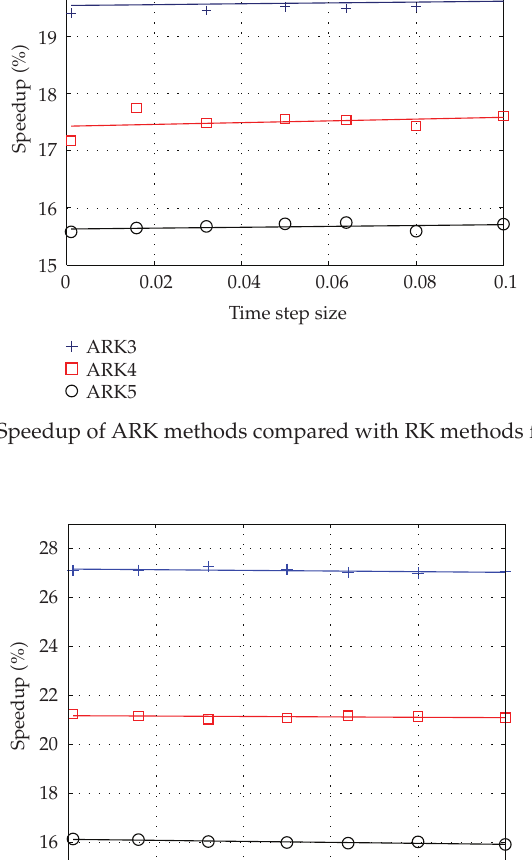
Figure 14 (cid:5) required by the ARK4 method is due to its lower computational overhead, which is produced by its simpler form as given in (cid:4) 2.5 (cid:5)